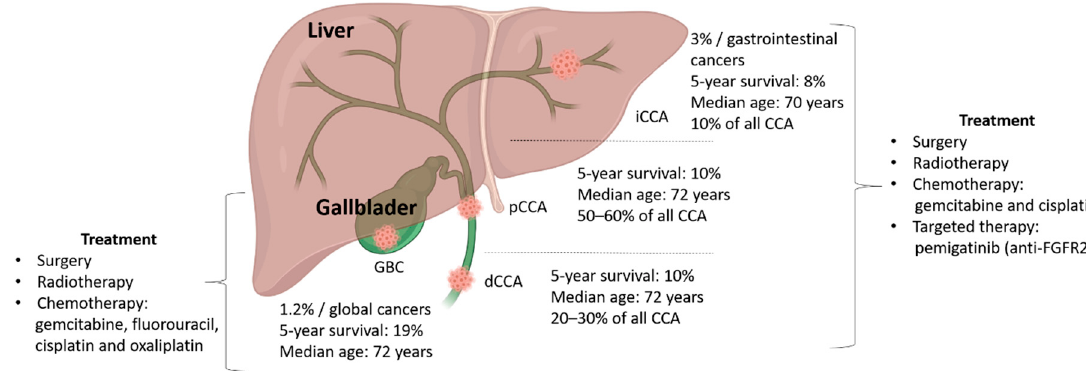
Figure 1. Schematic representation of the anatomic site, demographic information, and the treatment options for biliary tract cancers (BTCs). Abbreviations: dCCA: Distal cholangiocarcinoma (CCA); GBC: Gallbladder cancer; iCCA: Intrahepatic cholangiocarcinoma; pCCA: Perihilar CCA. Source: Cancer.Net.